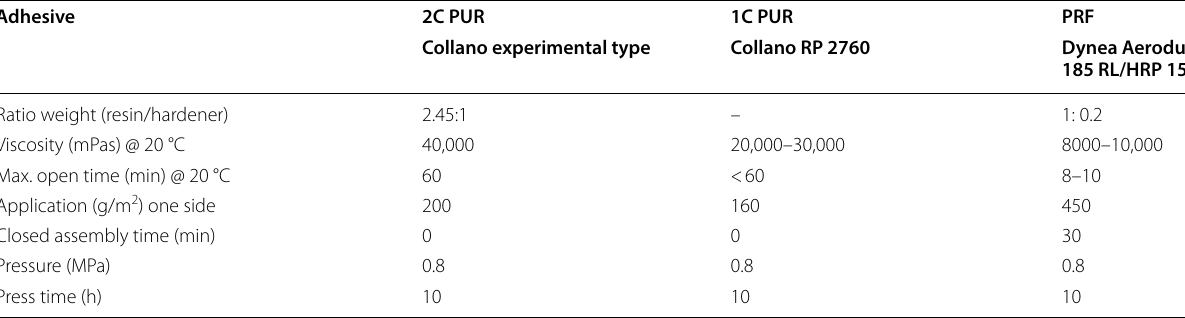
Table 1 Overview of adhesives, selected properties and processing parameters Adhesive